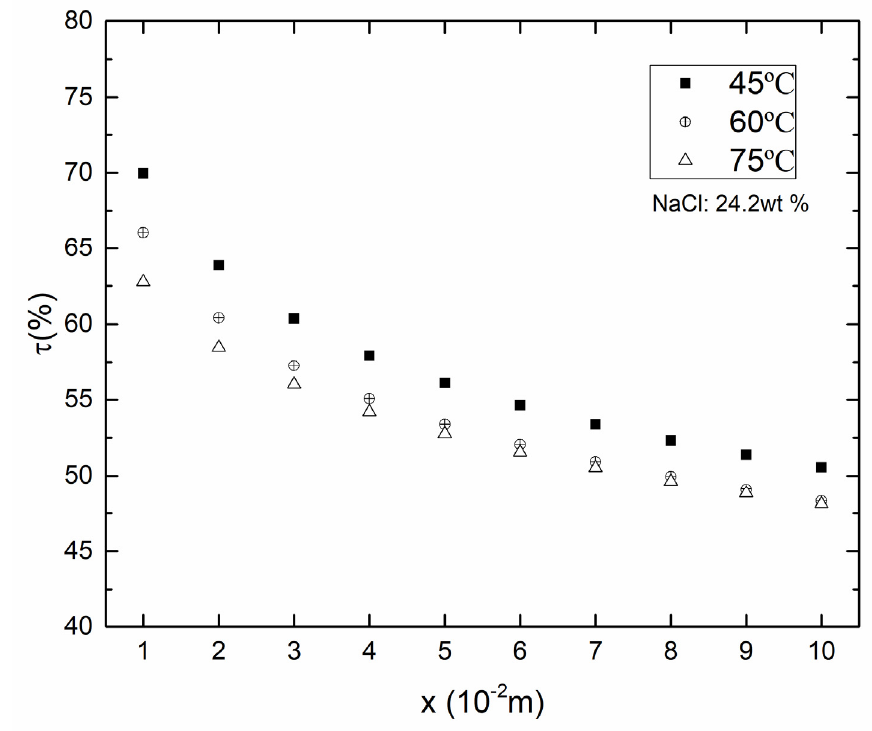
Figure 4. Contours of temperature distribution in different T f ( v f , v p = 0.15m/s, T p = 25 °C, c f = 24.2wt. %).